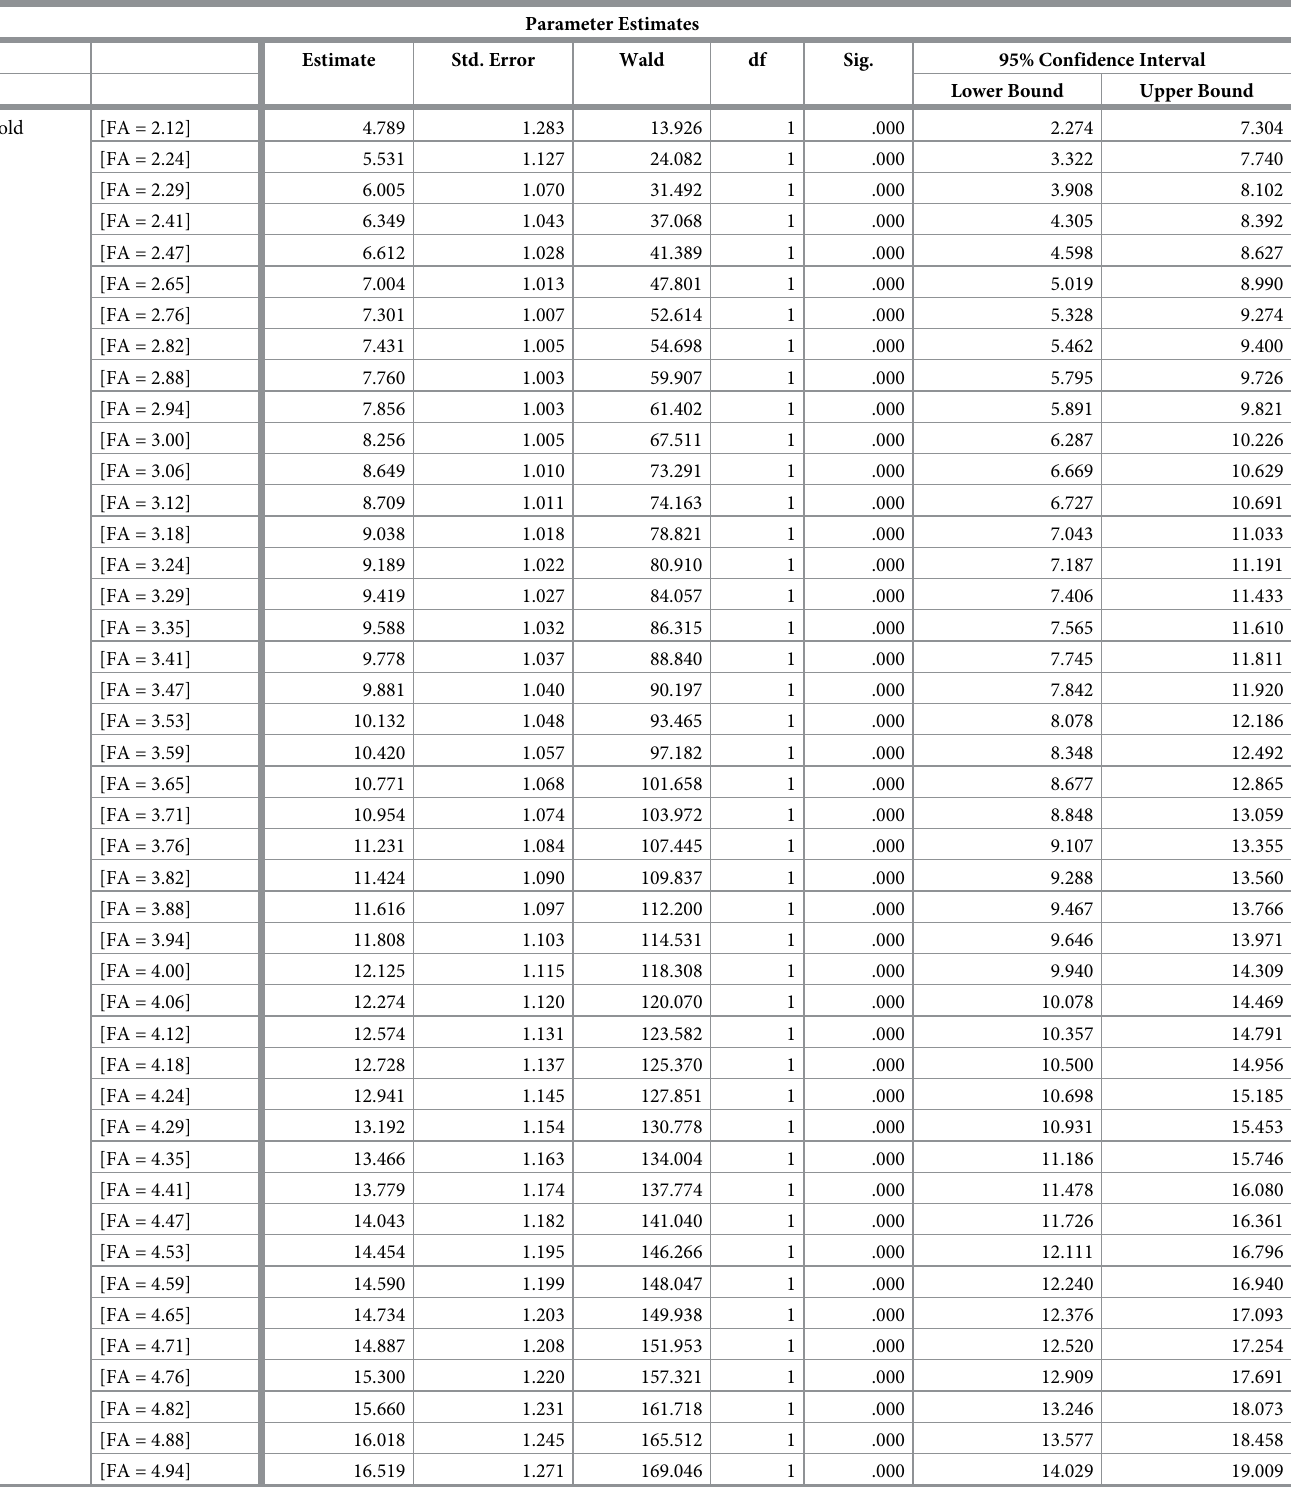
Table 2. Parameter estimate.